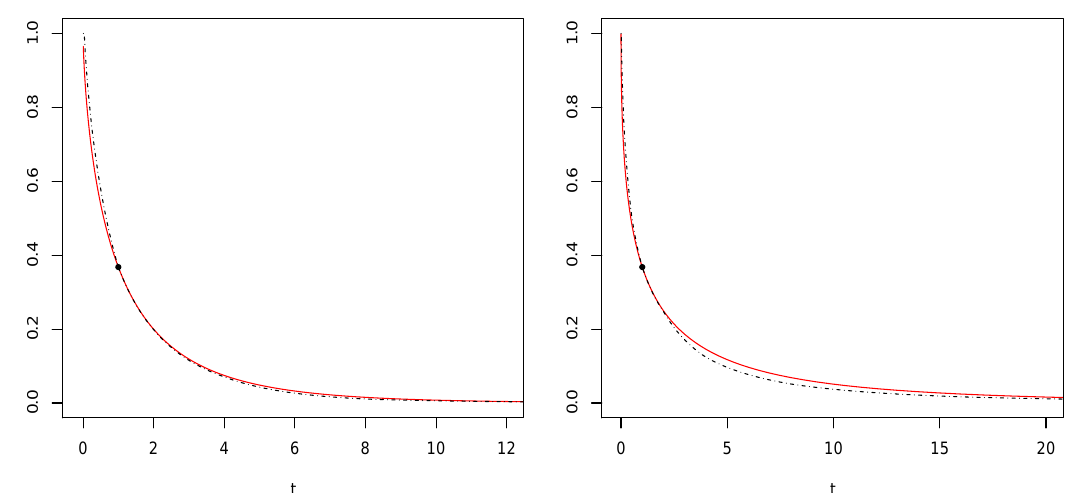
Figure 12. Non-parametric estimation of b φ ( t ) . (Left) Loss-ALAE data (black dotted line) and standardized Gumbel generator with parameter θ = 1 . 453 (red line). (Right) Framingham Heart study data (black dotted line) standardized Gumbel generator with parameter θ = 2 . 11 (red line). We force the generators to pass through the point ( t ,φ , e − 1 ) (black 0 0 ) = (1